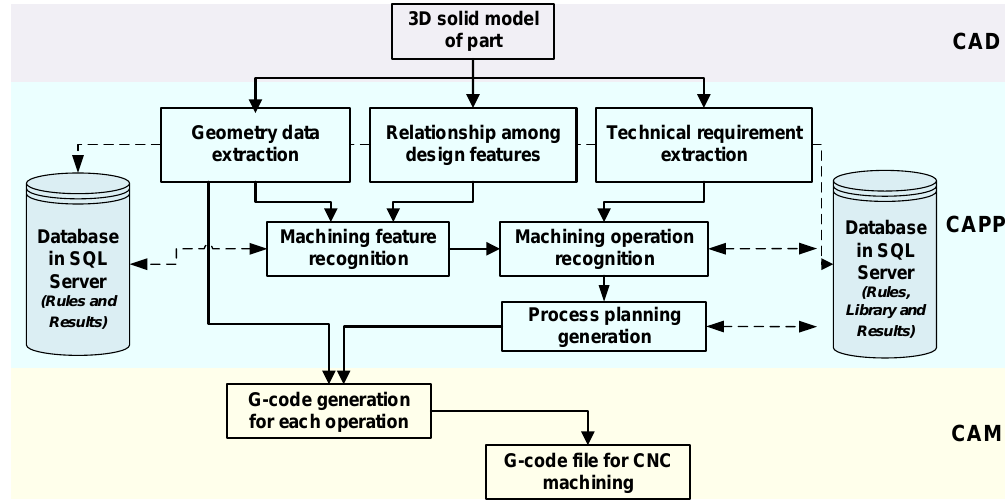
Figure 1. Principles of the integrated computer-aided design (CAD)–computer-aided process planning (CAPP)–computer numerical control (CNC) G-code flow.